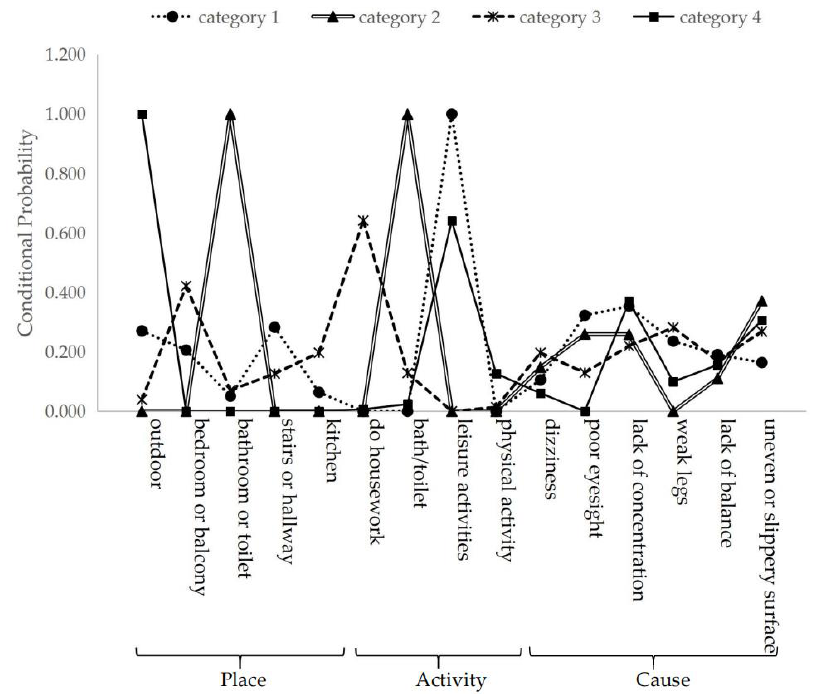
Figure 2. Conditional probability distribution of potential category model.